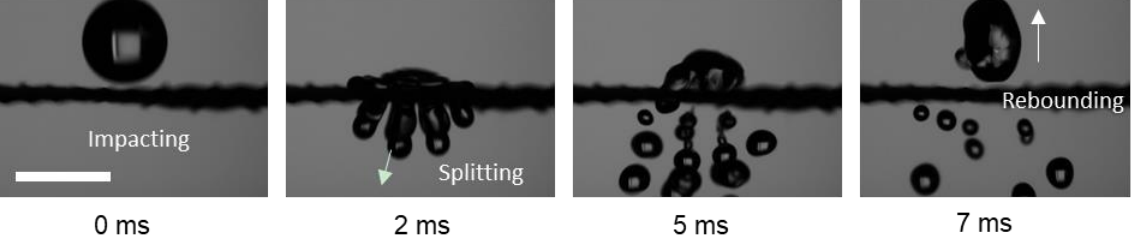
Figure 6. Breaking process of the droplet on the superhydrophobic mesh. The impacting velocity is 0.99 m/s. The mesh is NO. 2#. Scale bar is 3 mm.